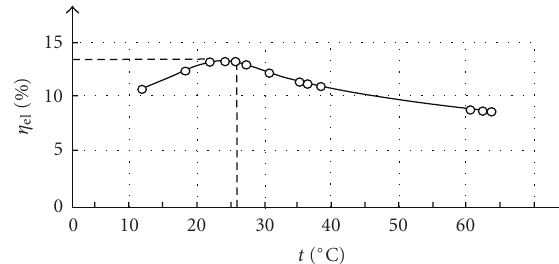
Figure 1: The photovoltaic e ffi ciency of the silicon solar cells/mod- ules in the function of temperature.